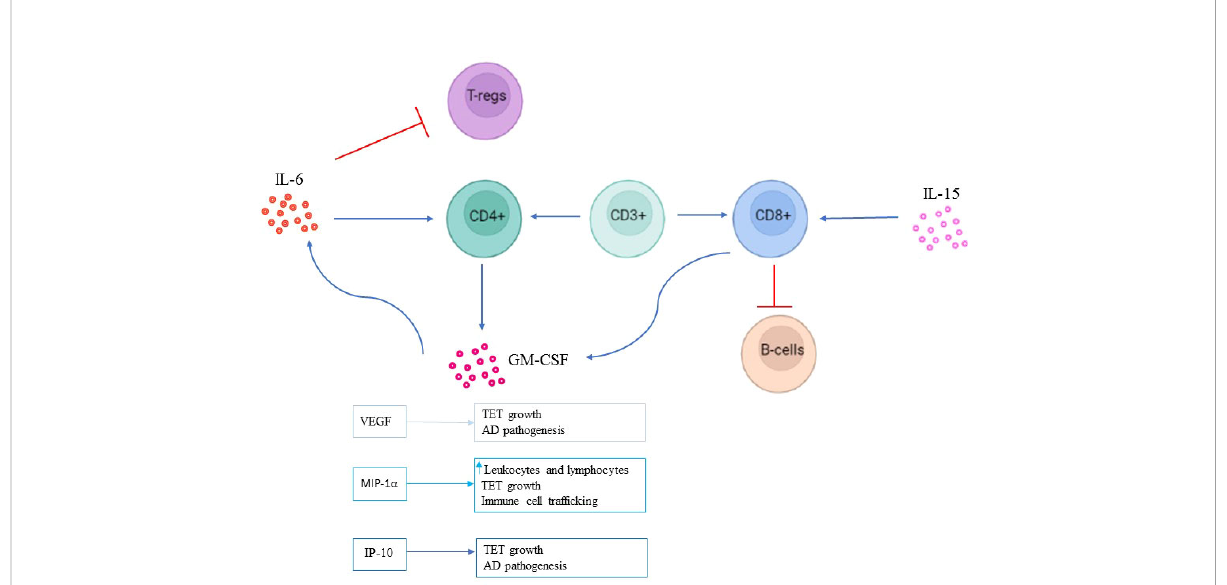
FIGURE 4 Potential mechanism in TET-AD patients. The presence of CD3+T cells is in fl uenced by pro-in fl ammatory cytokines able to regulate CD4+ and CD8+ T cell function in the context of TETs with GS and AD. IL-6 is known to promote autoreactive CD4+ T cells and inhibit Treg cells. We propose that IL-6 elicits both the reported functions in TET-AD patients enabling CD4+ T cells to secrete GM-CSF known to enhance IL-6 – dependent survival of CD4+ T cells. IL-6 might contribute to the decrease of Treg cells observed in TET-AD patients. On the other hand, IL-15 might support CD8+T cell function favoring its inhibitory effects on B cell development and likely inducing the secretion of GM-CSF by CD8+T cells that further sustains IL-6 activity. VEGF and IP-10 might exert a role in TET growth and in AD pathogenesis, whereas MIP-1 a might be also involved in TET growth, and in the observed increased numbers of leukocytes and lymphocytes and in immune cells traf fi